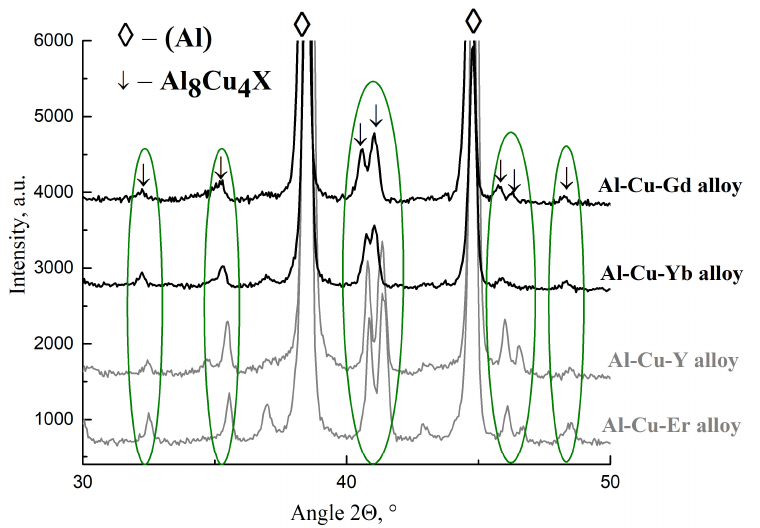
Figure 3. XRD-patterns of the Al-Cu-Yb and Al-Cu-Gd alloys in compare with the Al-Cu-Er [29] and Al-Cu-Y [27] alloys.